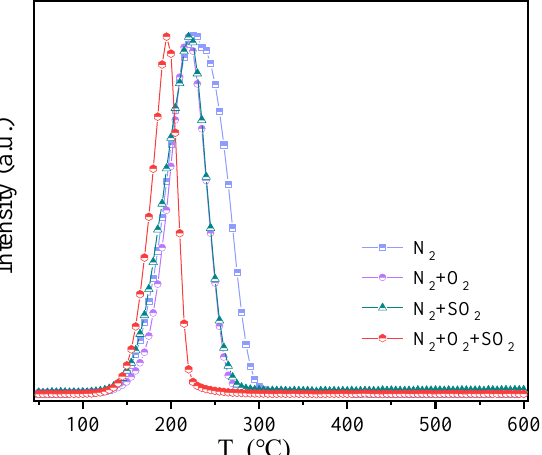
Figure 10. Cu 2p of spent c-CuS samples under pure N 2 , 6% vol SO 2 , 6% vol SO 2 + 6% vol O 2 , and 6% vol SO 2 + 6% vol O 2 +Hg 0 .